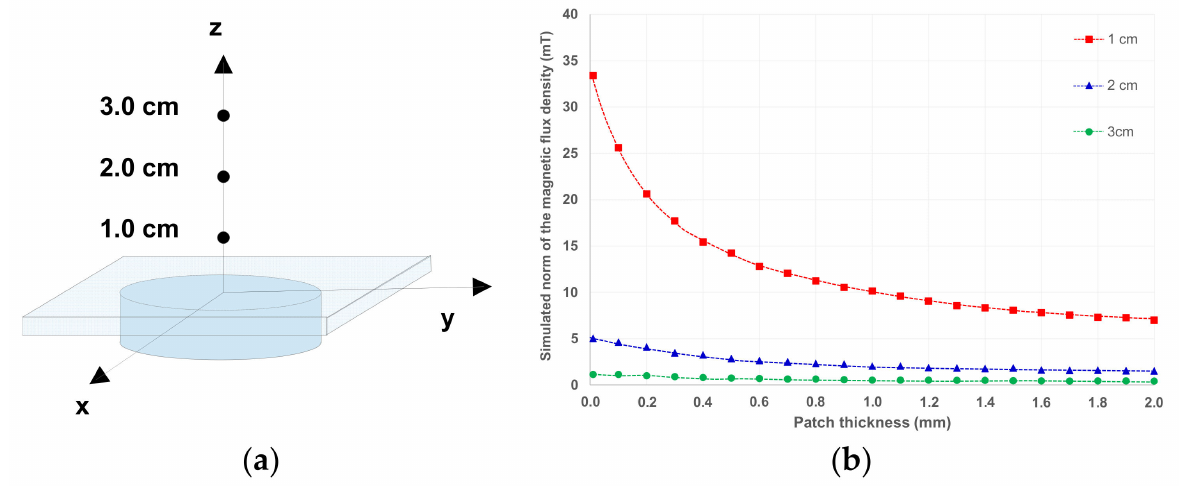
Figure 4. ( a ) Representation of the three measurement points located at 1.0, 2.0, and 3.0 cm from the center of the upper face of the permanent part along the z -axis of a simulated FMM; ( b ) values of the norm of the magnetic flux density, as a function of the patch thickness, for each of the three measurement